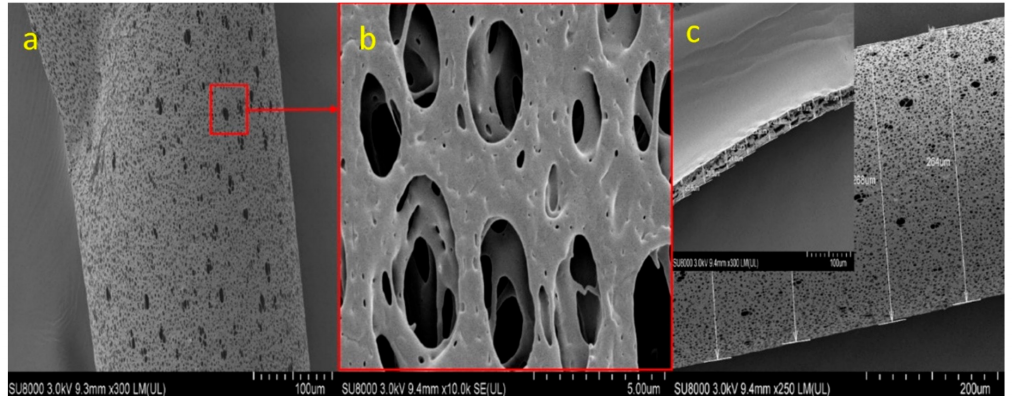
Figure 2. SEM micrographs of neat PAES hemodialysis membrane fiber surface: ( a ) whole microtubes; ( b ) the magnified surface image; ( c ) membrane diameter and